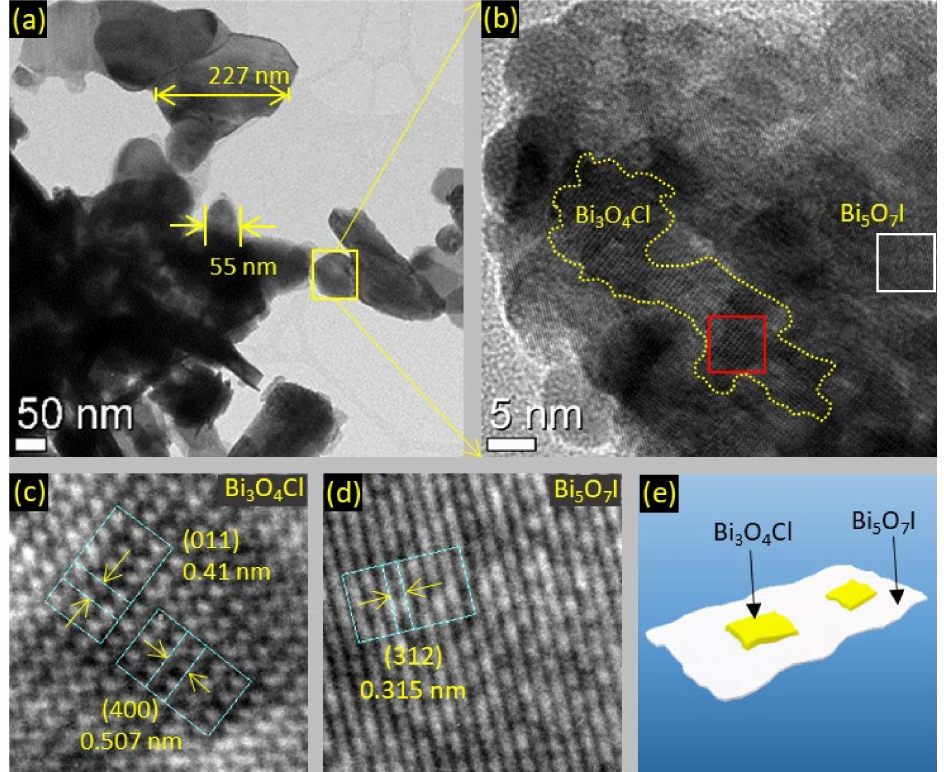
Figure 3. HRTEM images of ( a , b ) BOC/BOI-3 nano-platelets, ( c ) IFFT pattern of BOC and ( d ) BOI in BOC/BOI, and ( e ) schematic of BOC/BOI-3